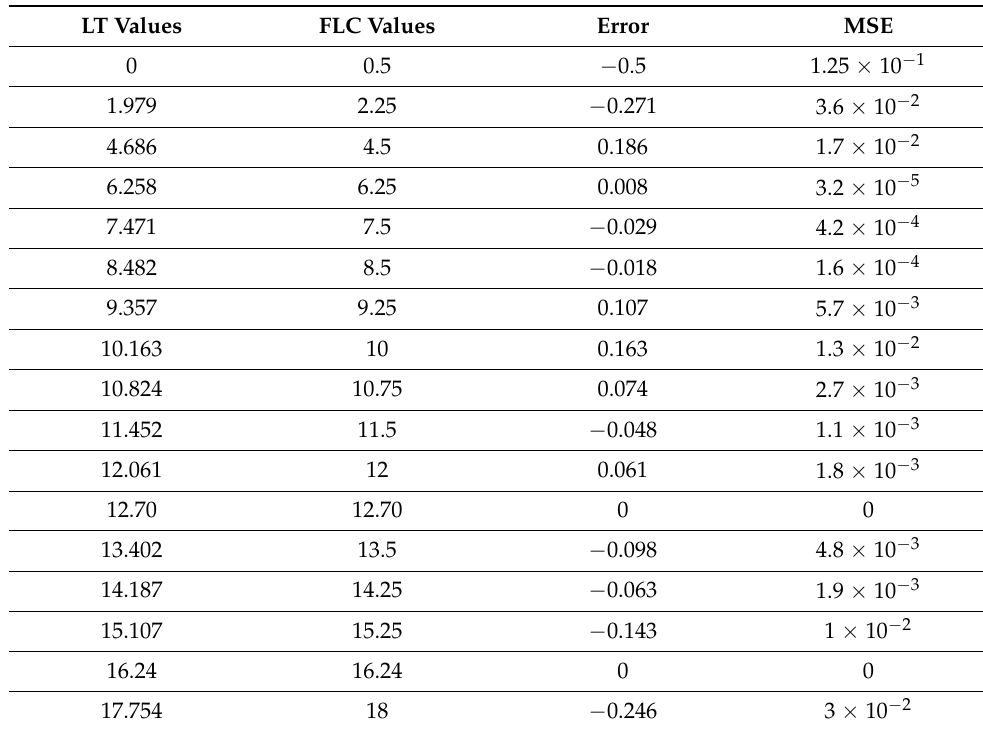
Table 3. Throttle estimation using FLC-based observer [41].